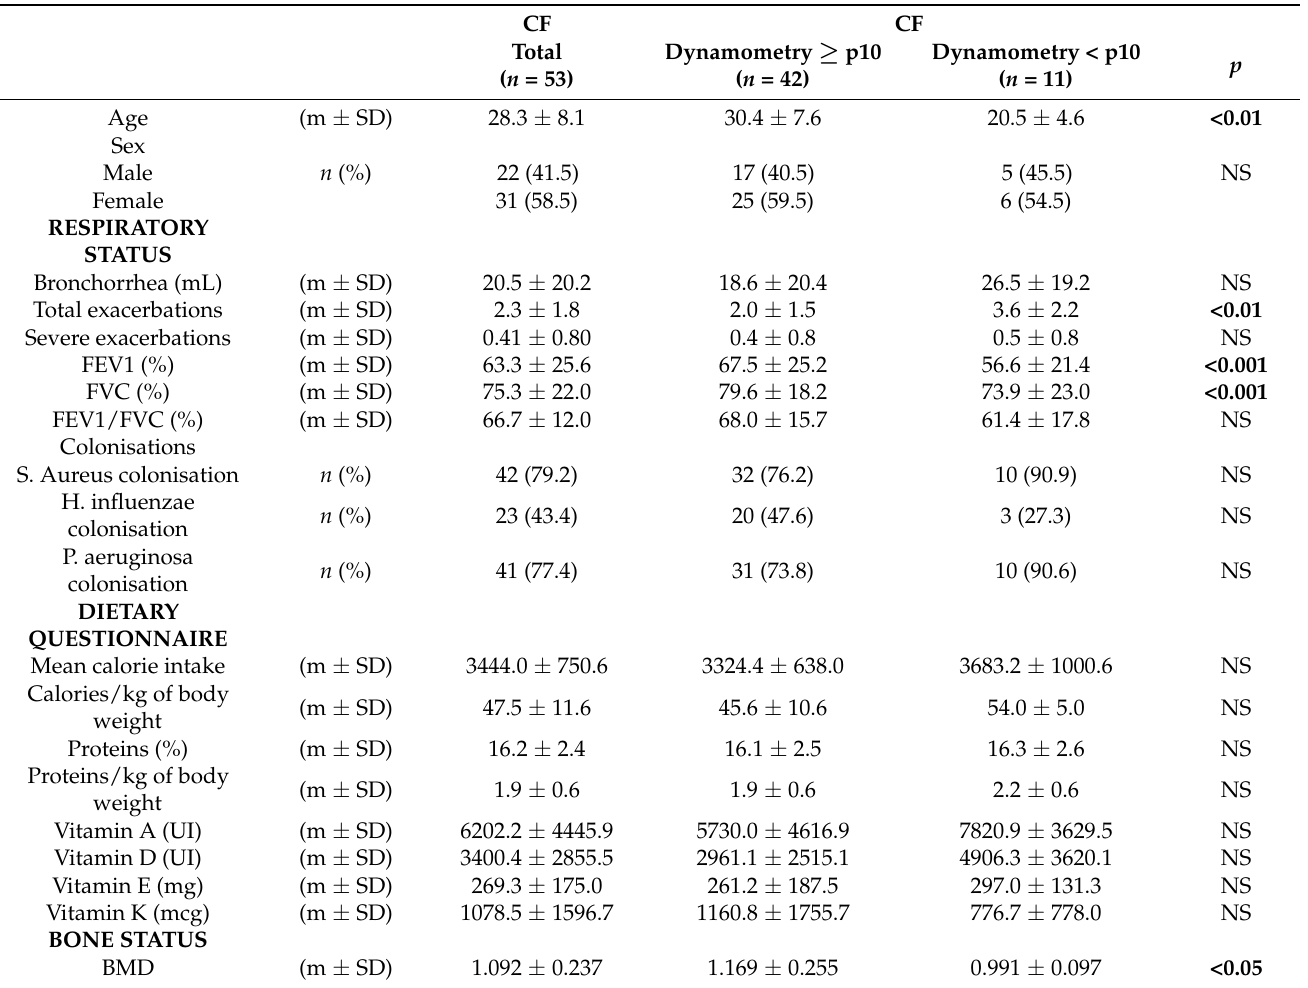
Table 1. General characteristics and respiratory, nutritional, and bone